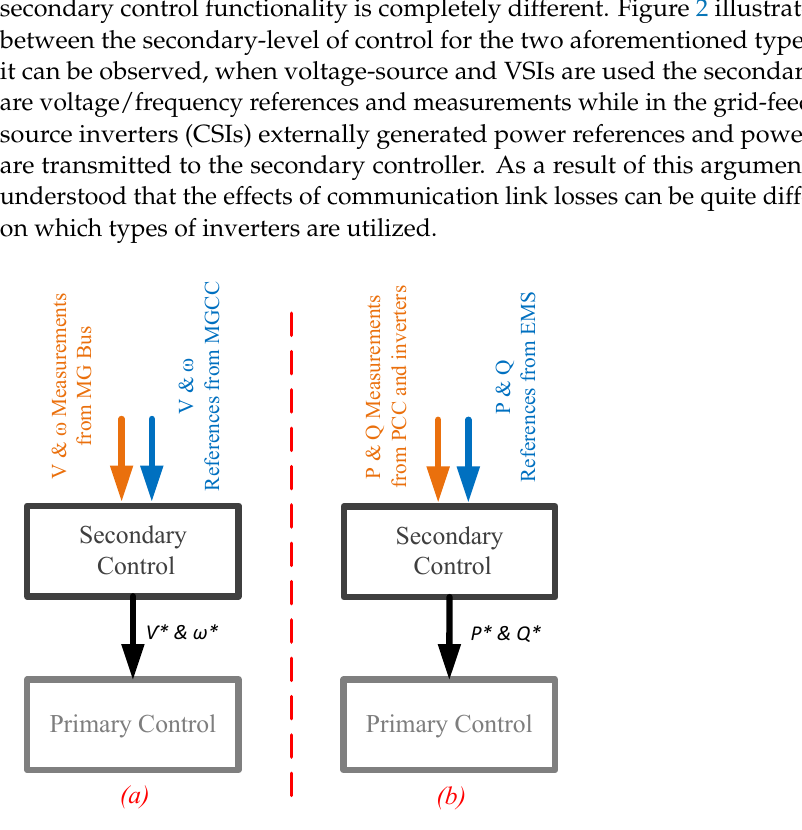
Figure 2. Secondary control for different types of inverters. ( a ) Grid-forming and VSI. ( b ) Grid-feeding and CSI. The values with a star superscript represent secondary control